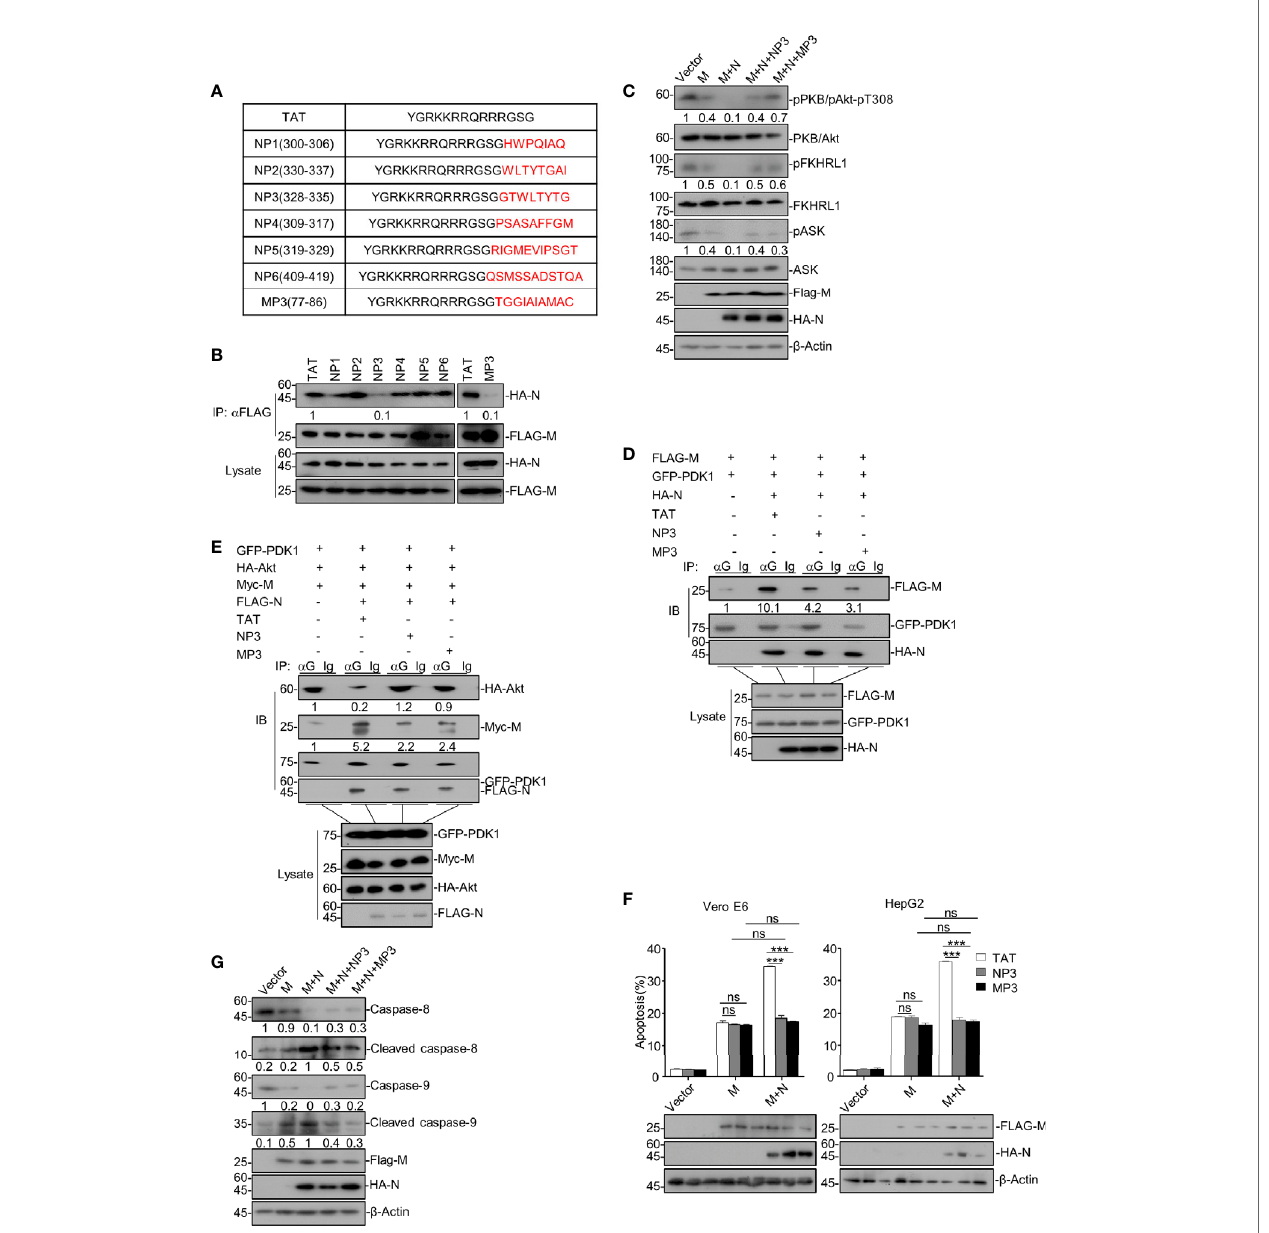
FIGURE 5 | Disrupting the M-N interaction abolishes the enhancing activity of N on M-induced apoptosis. (A) The amino acid sequences of TAT, NP1-6, and MP3. (B) HEK293T cells were transfected with FLAG-SARS-CoV-2 M and HA-SARS-CoV-2 N and treated with TAT, NP1-NP6, and TM3, respectively. After 24 h, cells were collected for co-immunoprecipitation (with anti-FLAG) and Western blotting (with anti-FLAG or anti-HA). (C) HEK293T cells were transfected with FLAG-SARS- CoV-2 M and FLAG-SARS-CoV-2 M plus HA-SARS-CoV-2 N, respectively. Cells expressing FLAG-SARS-CoV-2 M plus HA-SARS-CoV-2 N were treated with NP3 and MP3, respectively. After 24 h, cells were collected for Western blotting with antibodies to the indicated proteins. (D) HEK293T cells were transfected with FLAG-SARS-CoV-2 M, GFP-PDK1 together with HA-SARS-CoV-2 N and treated with TAT, NP3, and TM3, respectively. After 24 h, cells were collected for co-immunoprecipitation (with anti-GFP or IgG) and Western blotting (with anti-FLAG, anti-HA, or anti-GFP). (E) HEK293T cells were transfected with GFP-PDK1, HA-Akt, Myc-SARS-CoV-2 M together with FLAG-SARS-CoV-2 N and treated with TAT, NP3, and TM3, respectively. After 24 h, cells were collected for co- immunoprecipitation (with anti-GFP, or IgG) and Western blotting (with anti-FLAG, anti-HA, anti-Myc, or anti-GFP). (F) Vero E6 and HepG2 cells were transfected with FLAG-SARS-CoV-2 M and SARS-CoV-2 M plus HA-SARS-CoV-2 N and treated with TAT, NP3, and TM3, respectively. After 24 h, cells were collected for Western blotting (with anti-FLAG, anti-HA, or anti- b -Actin) or stained with Annexin V-FITC/PI for fl ow cytometry analysis, and the percentage of apoptotic cells were measured. (G) HEK293T cells were transfected with FLAG-SARS-CoV-2 M and FLAG-SARS-CoV-2 M plus HA-SARS-CoV-2 N, respectively. Cells expressing FLAG-SARS-CoV-2 M plus HA-SARS-CoV-2 N were treated with NP3 and MP3, respectively. After 24 h, cells were collected for Western blotting with antibodies to the indicated proteins. *** P < 0.001 by two-tailed Student ’ s t-test. ns, non signi fi cant. The densities of blots were analyzed with ImageJ